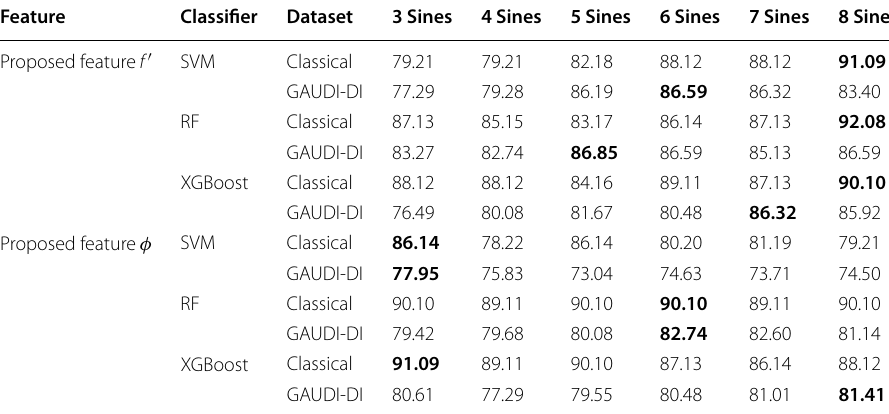
Bold means the best performance of tampering detection in the same experimental setting